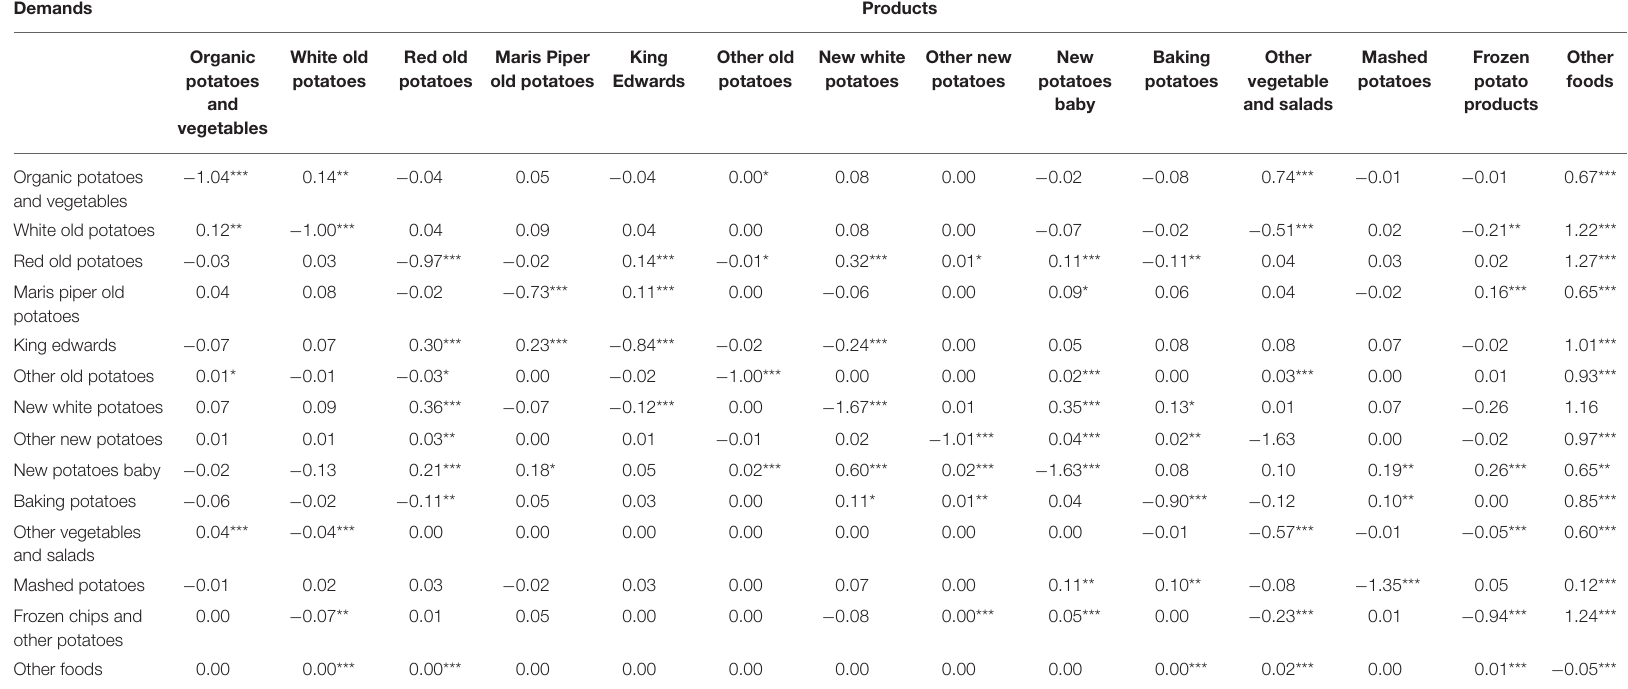
TABLE 4 | Uncompensated demand elasticities for fresh and processed potatoes in the United